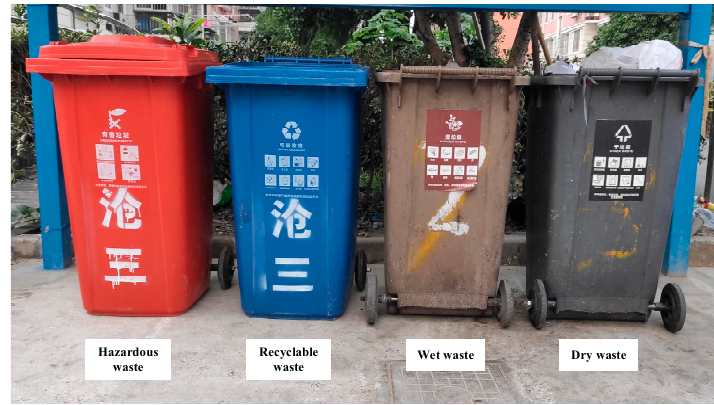
Figure 1. Collection bins of different categories of waste.